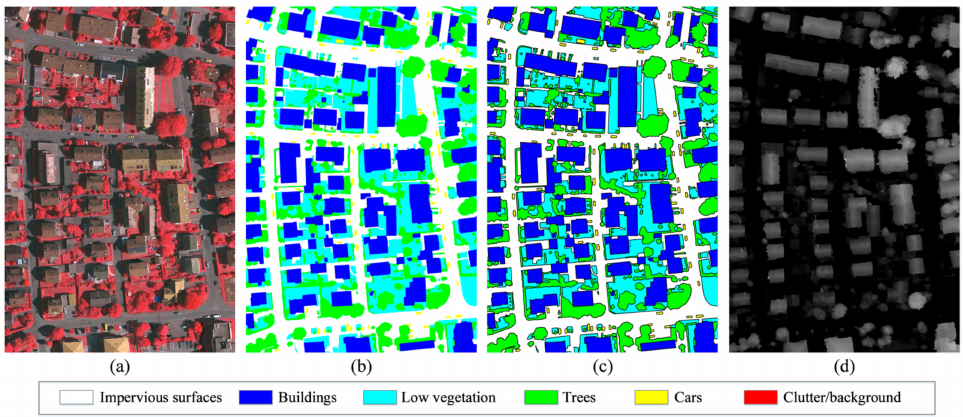
Figure 4. Examples of Vaihingen dataset. ( a ) Aerial image; ( b ) ground truth; ( c ) ground truth with eroded boundaries (black areas will be ignored); ( d ) corresponding Normalized Digital Surface Model